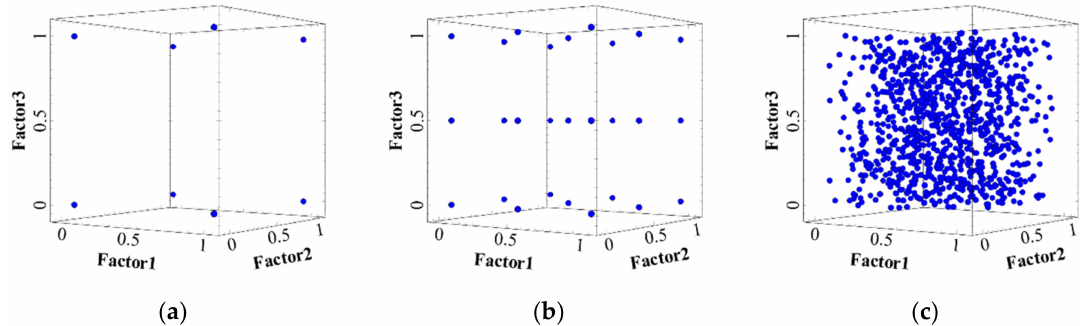
Figure 1. Comparison of data sampling methods: ( a ) two level full/fractional factorial design; ( b ) three level full factorial design; and ( c ) Latin hypercube sampling